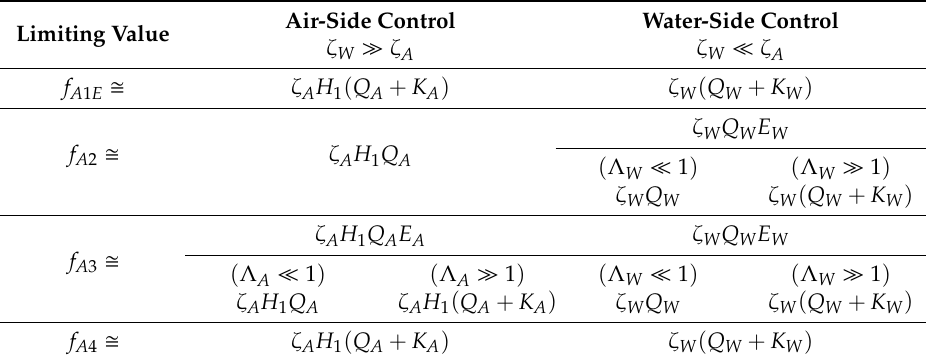
Table 3. Results of all models simplify in certain